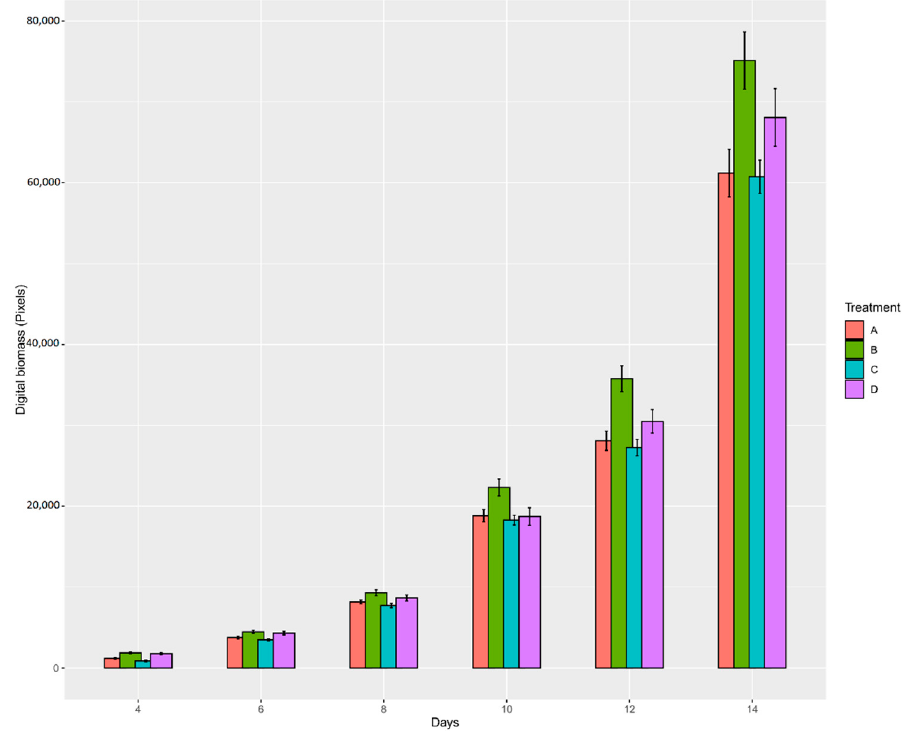
Figure 9. ( A ) Sugar beet experiment installed in Phenocave; ( B ) individual image of sugar beet plants per tray; ( C ) image after processing with the developed pipeline.